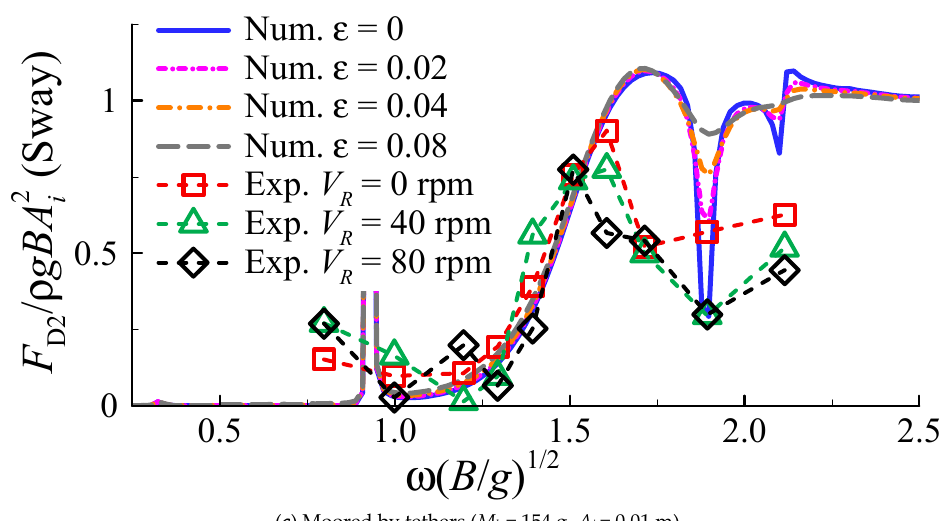
Figure 16. Influence of viscous damping of water oscillations in moonpools on mean sway drift force of a barge in beam waves. The results are calculated using WAMIT using the far-field method. ( ε is the damping coefficient).